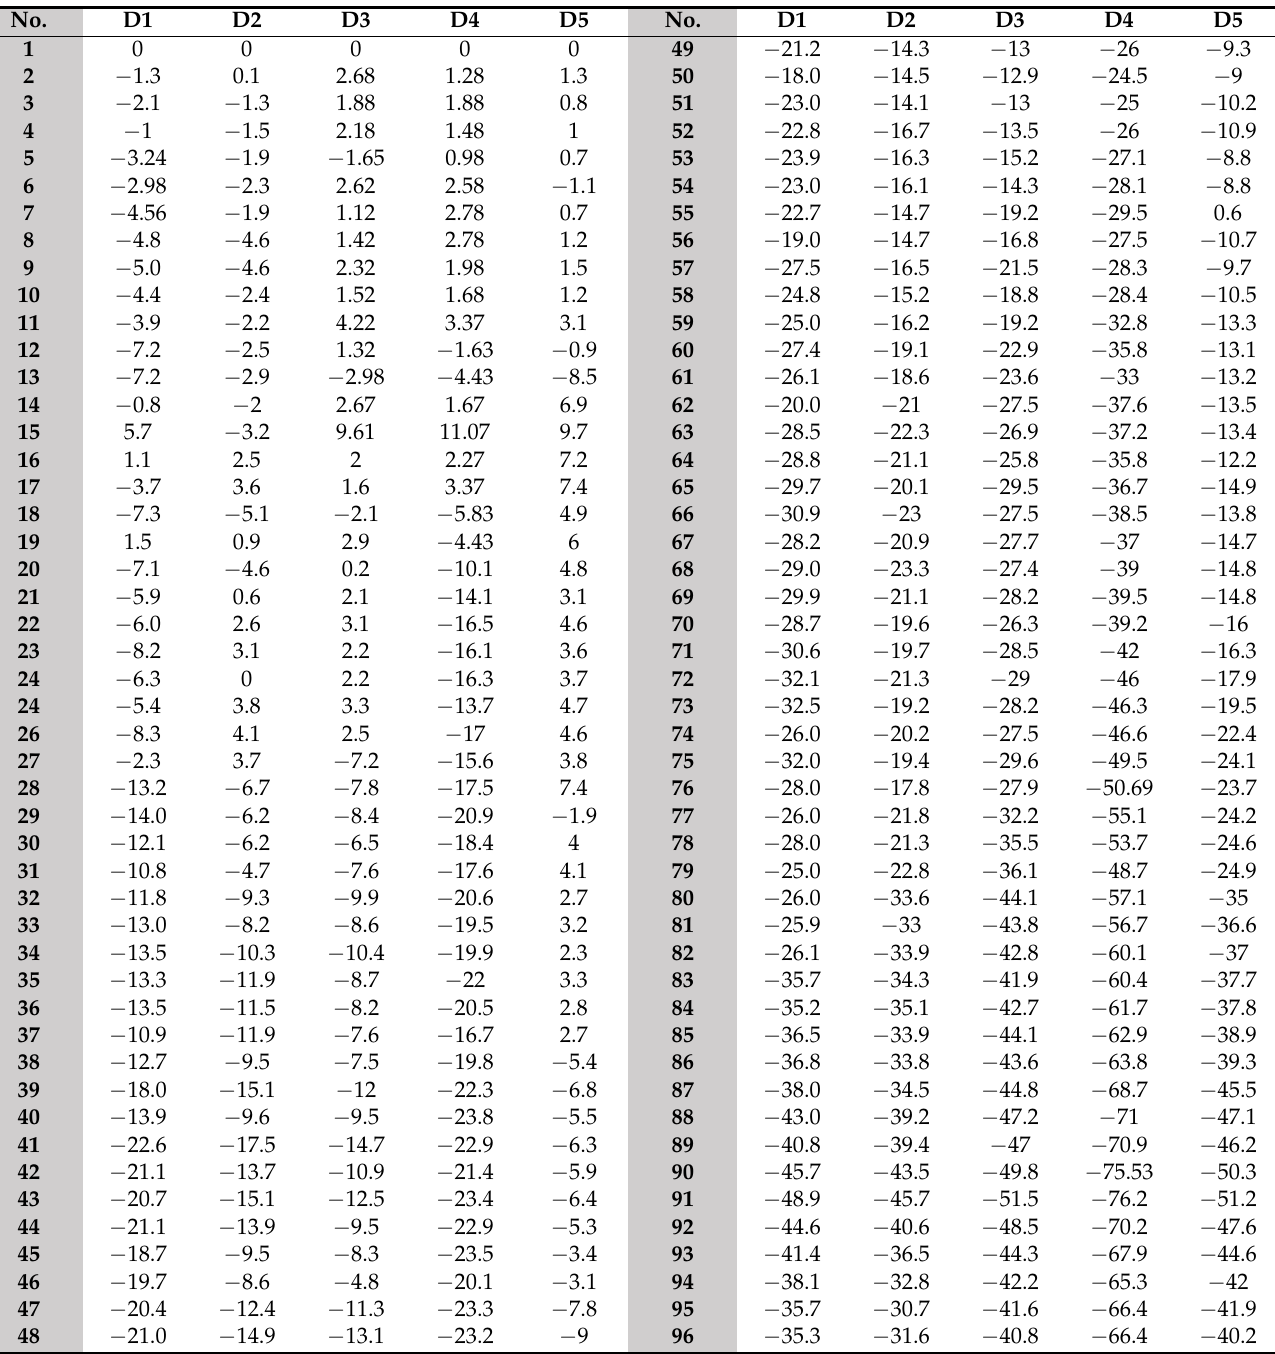
Table 4. Time series working conditions of PS points on bridge